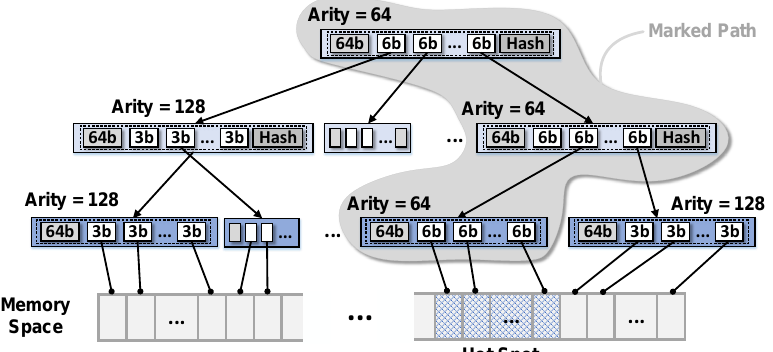
Figure 10. The structure of